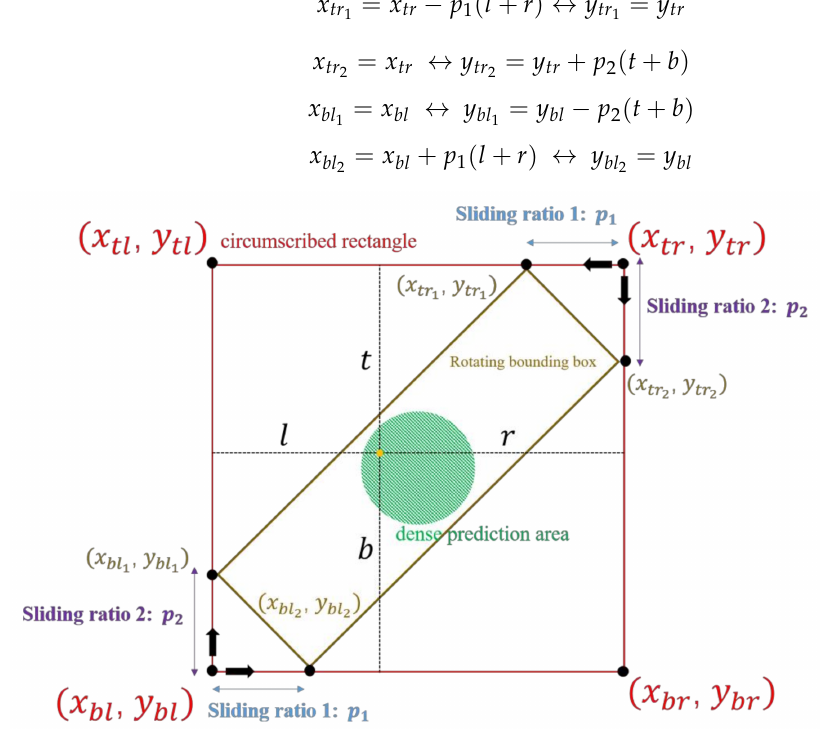
Figure 7. Example of a regression process for a rotating bounding